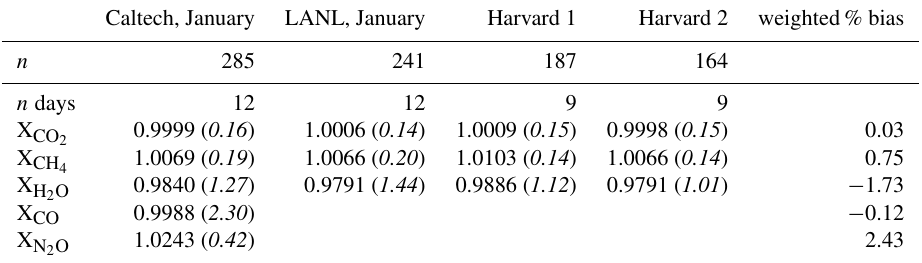
Table 3. EM27/SUN to Caltech TCCON biases.